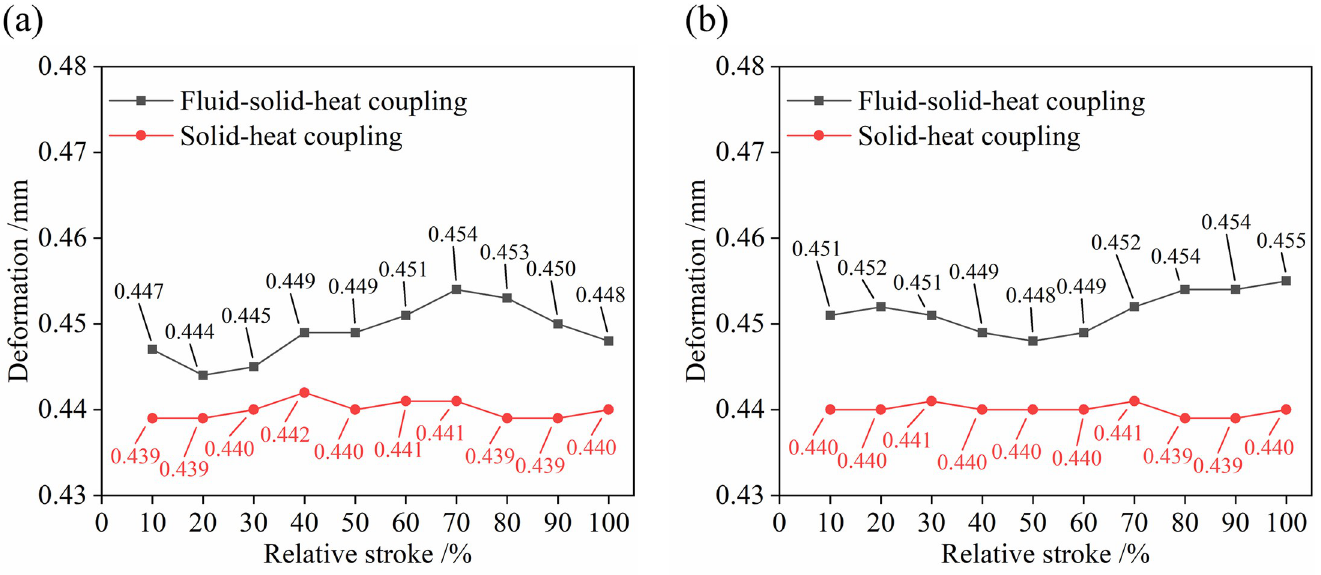
PLOS ONE | https://doi.org/10.1371/journal.pone.0263076 January 25,